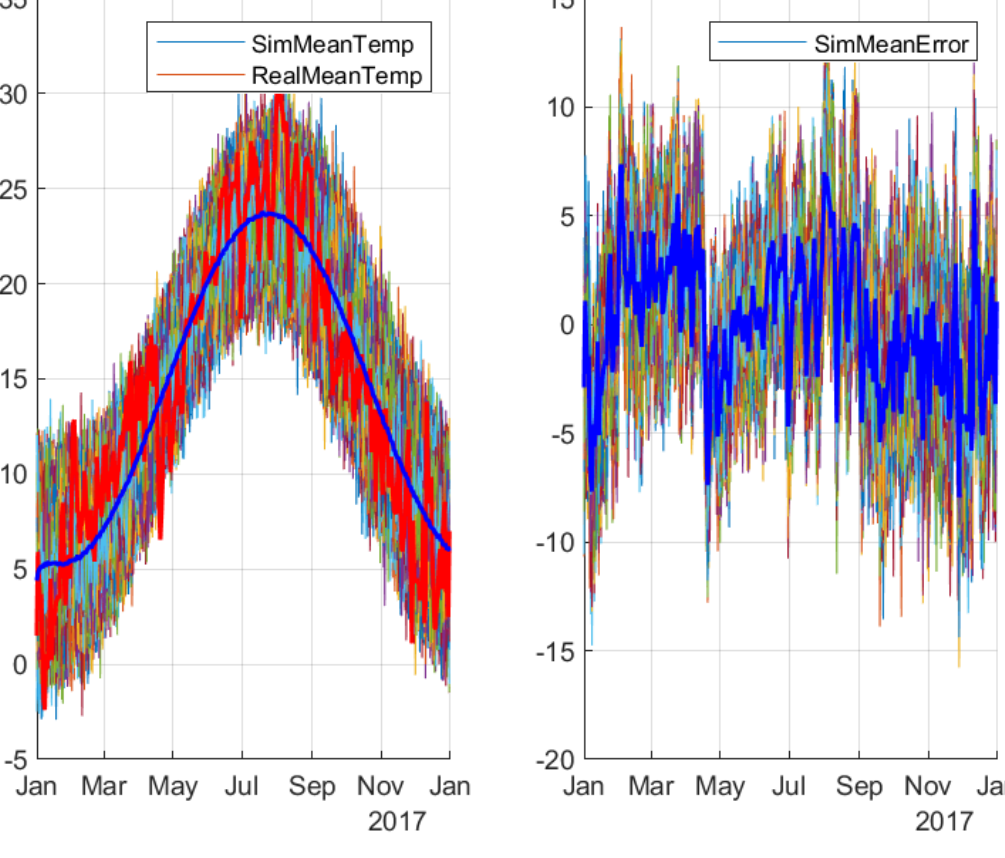
Figure 8. Simulated mean temperature and errors for each trajectory for year